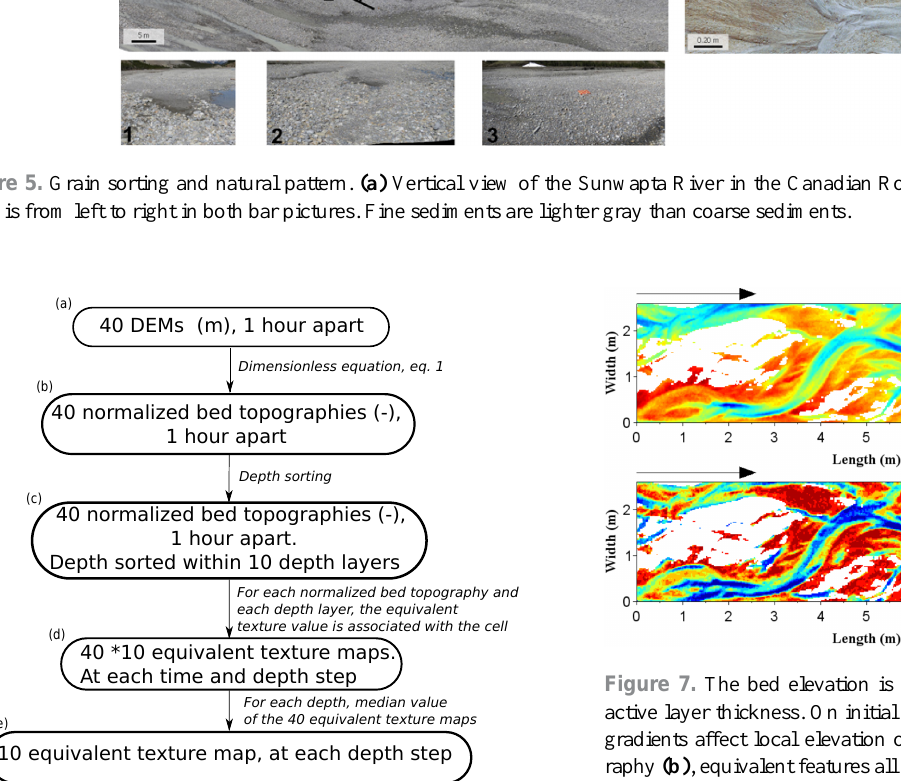
Figure 6. Construction of the texture maps: (a) the bed topogra- phy derived from the photogrammetry process, (b) the normalized bed topography using Eq. (1), (c) normalized bed topography sorted in 10 layers (the minimum and maximum surface are not included in the layers), (d) 400 equivalent texture maps, and (e) 10 median equivalent texture maps for each normalized bed depth.